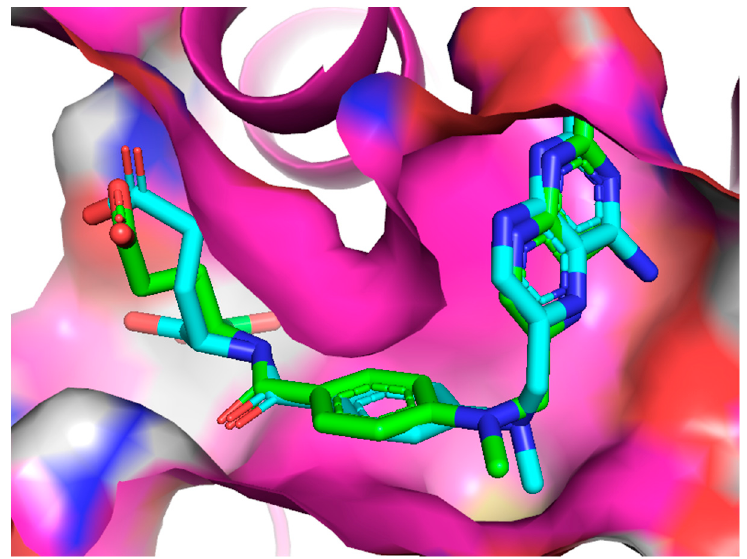
Figure 6. The alignment of the MTX ligand inside the active site of DHFR from the redocking studies (blue), compared to the experimental structure (green).